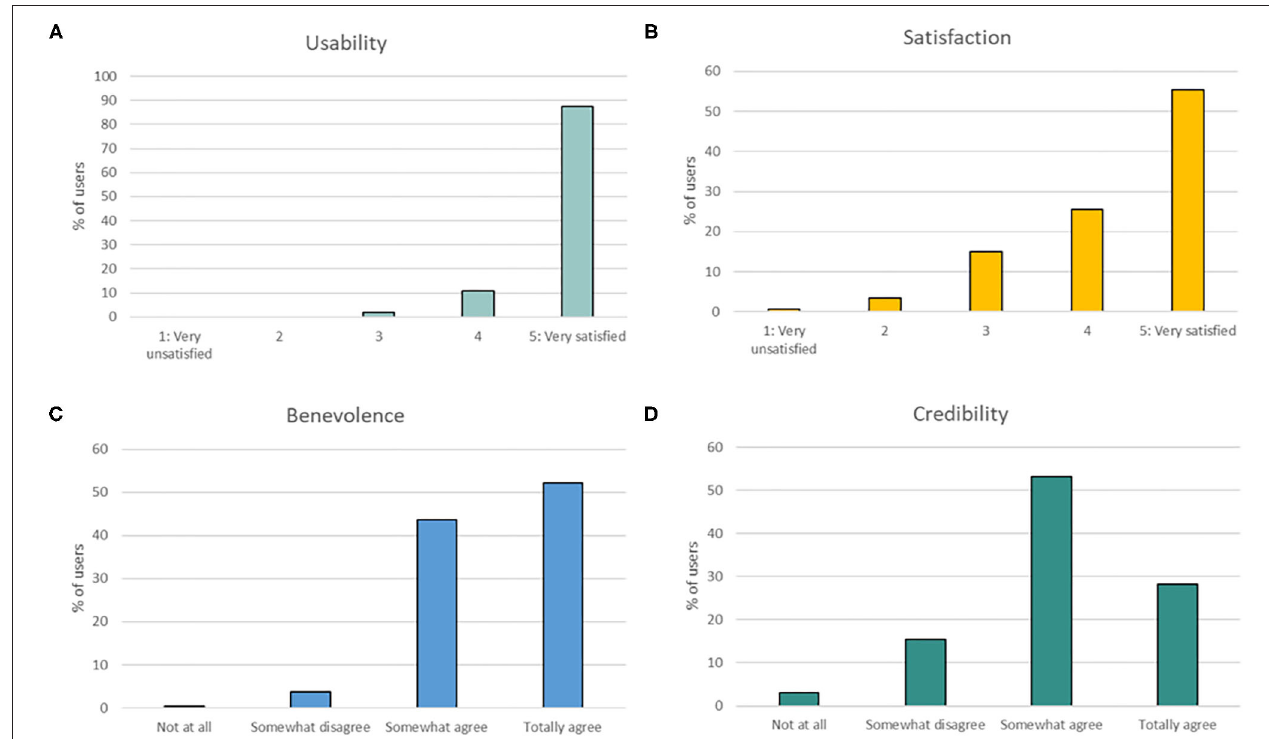
FIGURE 2 | Perception of usability, satisfaction of KANOPEE, and benevolence and credibility of the virtual agent (Jeanne). (A) Percentage of users’ rating for the usability dimension (AES subscore), (B) percentage of users’ rating for the satisfaction dimension (AES subscore), (C) percentage of users’ rating for the benevolence dimension (ETQ subscore), and (D) percentage of users’ rating for the credibility dimension (ETQ